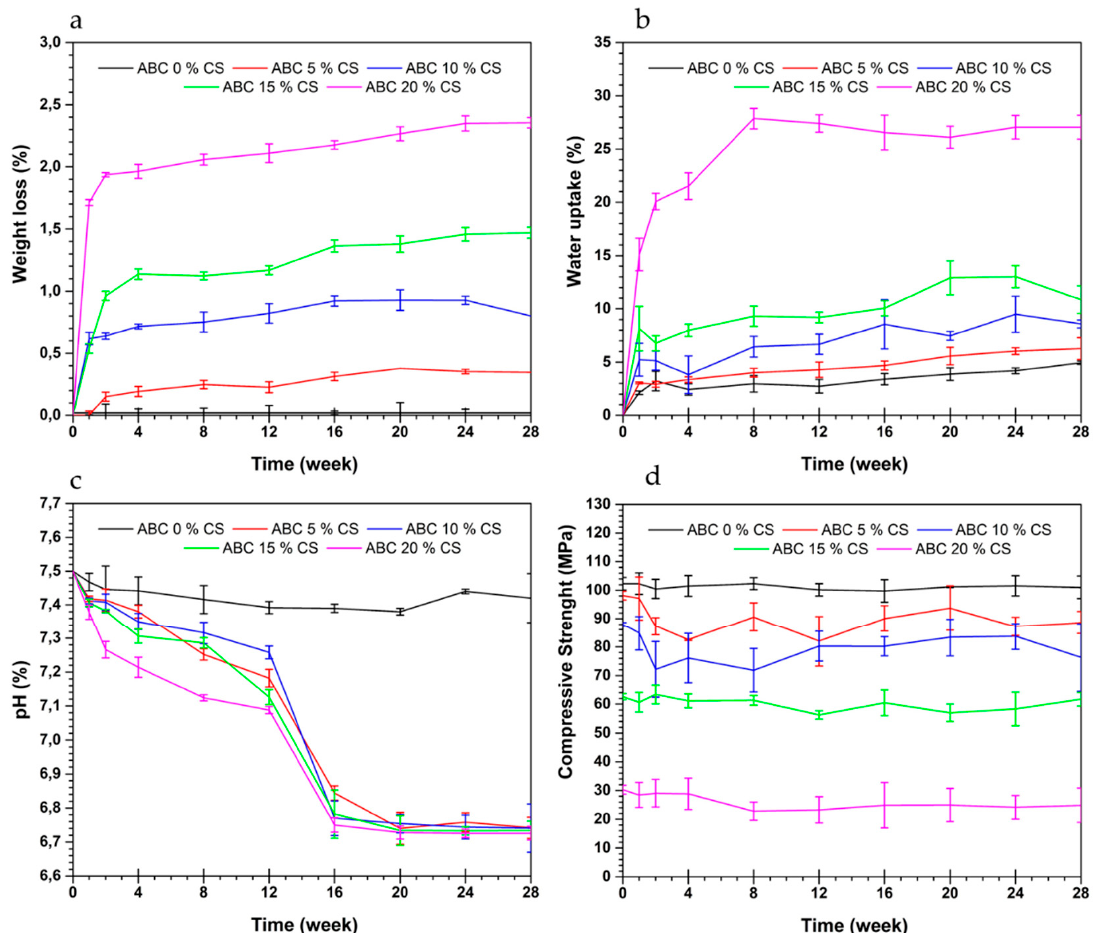
Figure 6. Effect of soaking time in a simulated body fluid of acrylic bone cements loaded with CS on ( a ) weight loss, ( b ) water uptake, ( c ) pH, and ( d ) compressive strength.